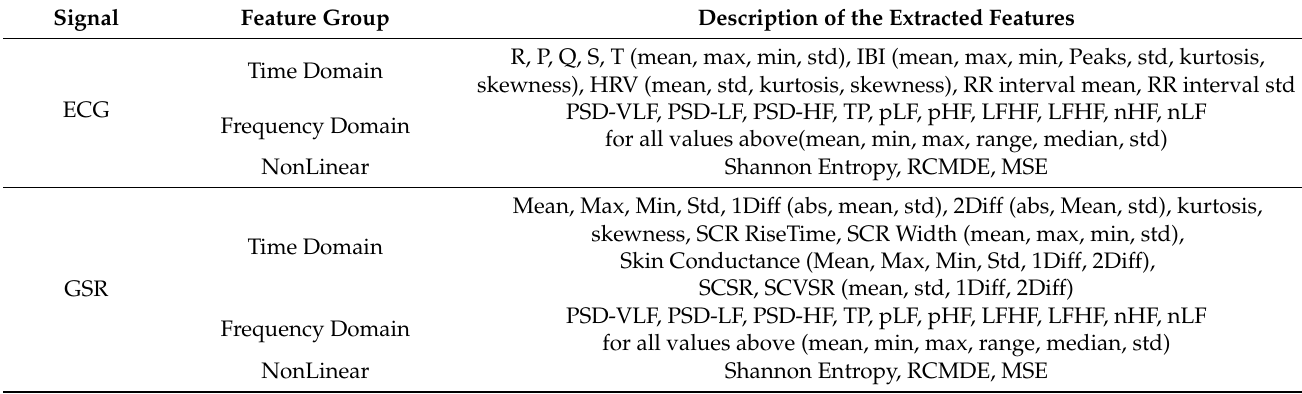
Table 1. Summary of extracted